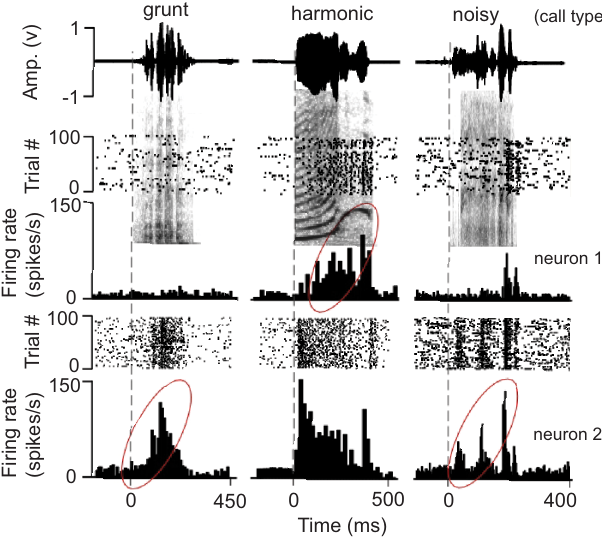
Figure 4. Responses of collicular neurons to communication sounds . Amplitude envelops (top) and raster and PSTH (10 ms bins) plots superimposed on call spectrographs of three different call types (grunt, harmonic, noisy) to show the response of 2 neurons (neuron 1 is from a female and neuron 2 is from a male) in the monkey inferior colliculus. Each call presentation was repeated 40 times per histogram. Grey vertical dotted lines indicate sound onset. Note the response build-up to the third predominant amplitude modulation in the last call. Average first peak response latency to calls was 20.9 +/- 3.5 ms (n = 10). Responses with a potential for temporal facilitation are enclosed by ellipses, although response enhancement may also depend on the basic acoustic patterns within complex sounds or on amplitude tuning. Calls were downloaded from the following web site: http://www.soundboard.